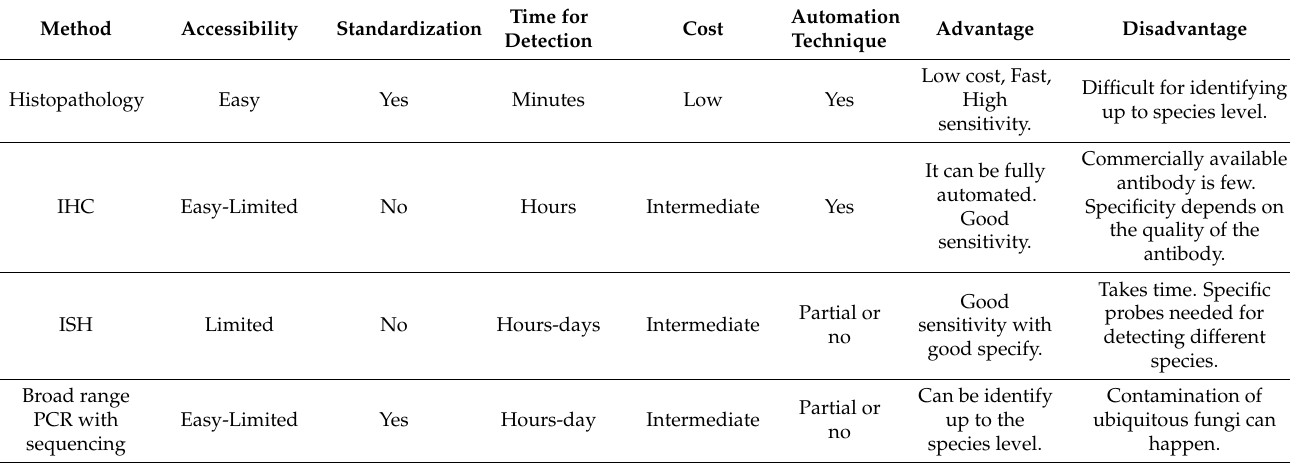
Table 2. The available approaches for identifying fungal species in